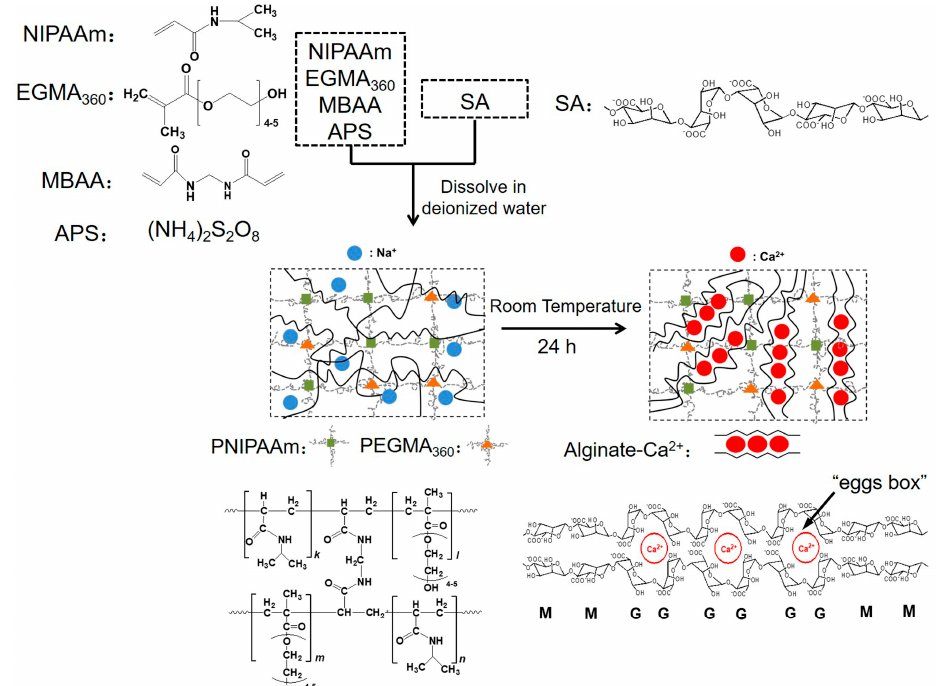
Figure 1. Schematic illustration of the preparation of hydrogels (M represents (1-4)-linked β - D - mmannuronic acid monomer and G represents α - L -guluronic acid monomer).